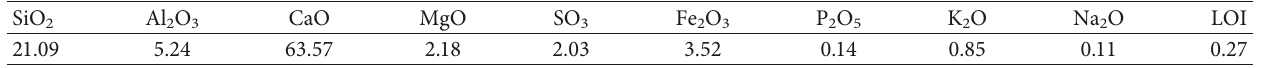
Table 2: Chemical composition of the OPC.